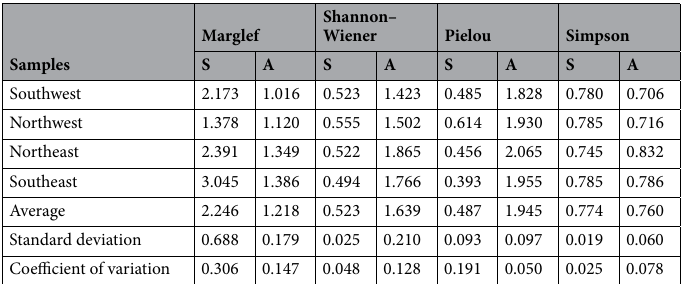
Table 5. Diversity distribution of woody layer outside tiankeng. S showed shrub layer; A showed arbor layer.